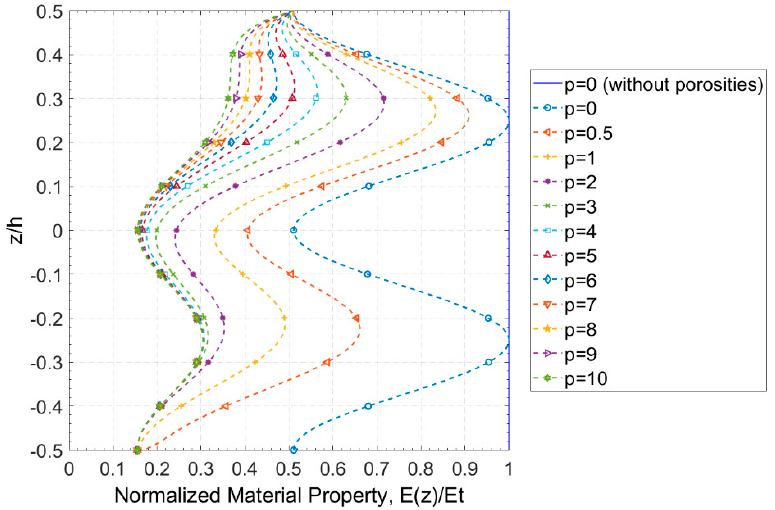
Figure 5. Porosity model M3: normalized Young’s modulus (E(z)) through the thickness. Note that on the upper surface the normalized Young’s modulus takes the same value for all power law exponents evaluated once the equality E ( z ) = E t ( 1 − e 0 β ) is verified. On the opposite surface, Young’s modulus is given by E ( z ) = E b ( 1 − e 0 β ) , which justifies the fact that the corresponding p = 0 curve constitutes an exception from the others, since this particular case corresponds to a plate bottom face corresponds to the phase with Young’s modulus given by E b